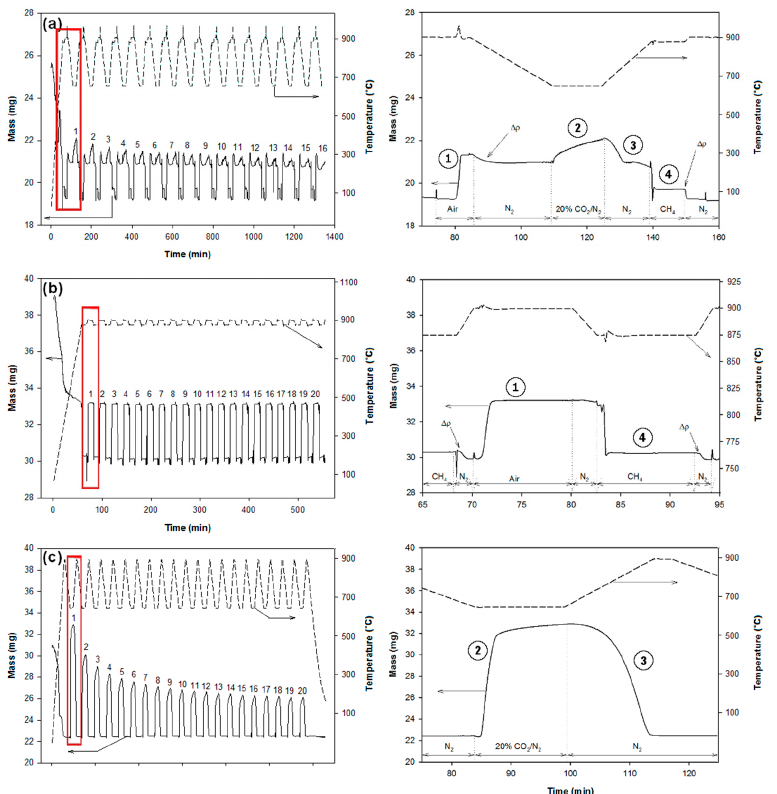
Figure 2. Mass (left axis) and temperature (right axis) profiles recorded by TGA during multiple CaL and/or CLC cycles for ( a ) CaO/CuO/CE pellets; ( b ) CuO/CE pellets; and ( c ) CaO/CE pellets. The graphs in the right column are magnifications of the highlighted sections of each respective graph. ① oxidation, ② carbonation, ③ calcination, ④ reduction. Δρ are differences of buoyancies due to either the change of temperature or change of gas.